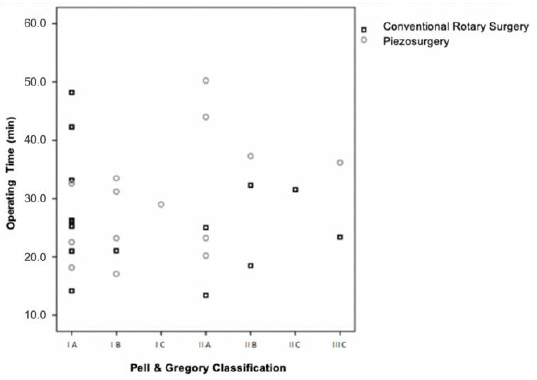
Figure 5. Operating time vs. surgical difficulty (Pell and Gregory) vs. surgical technique ( p = 0.388 for the conventional rotary surgery and p = 0.030 for the piezosurgery).